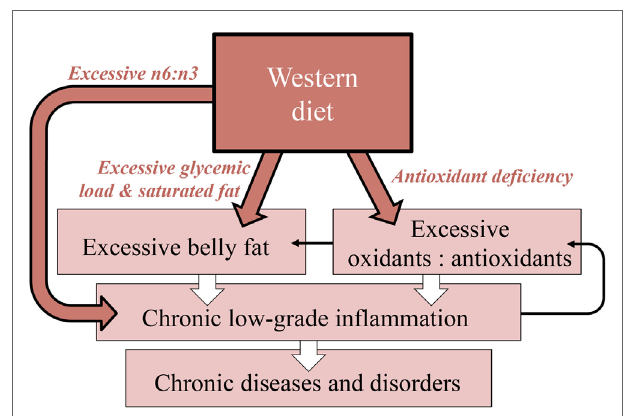
FiguRe 3 | Diagram of the synergistic interaction among key nutritional features of the western diet in promoting chronic diseases and disorders . Highlighted are the mechanistic links of how these factors promote excessive belly fat, and how this belly fat, together with excessively high ratios of omega-6 to omega-3 fatty acids and of oxidants to antioxidants, trigger chronic low-grade inflammation (wide arrows). Thin arrows indicate additional feed-forward loops between these processes [see, e.g., Ref. (56)]. n 6: n 3, ratio of omega-6:omega-3 fatty acids; GL, glycemic load; SF, saturated fat, AO, antioxidants.